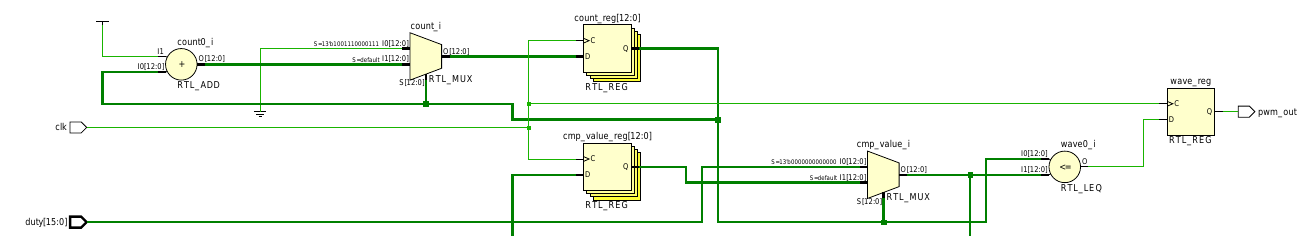
Figure 19. RTL schematic diagram of PWM signal generation module.